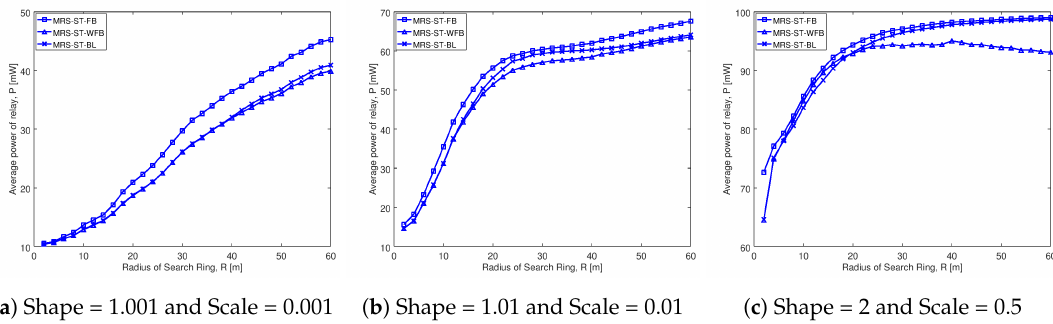
Figure 8. Average transmission power comparison of various schemes in different social trust scenarios when network width is 100